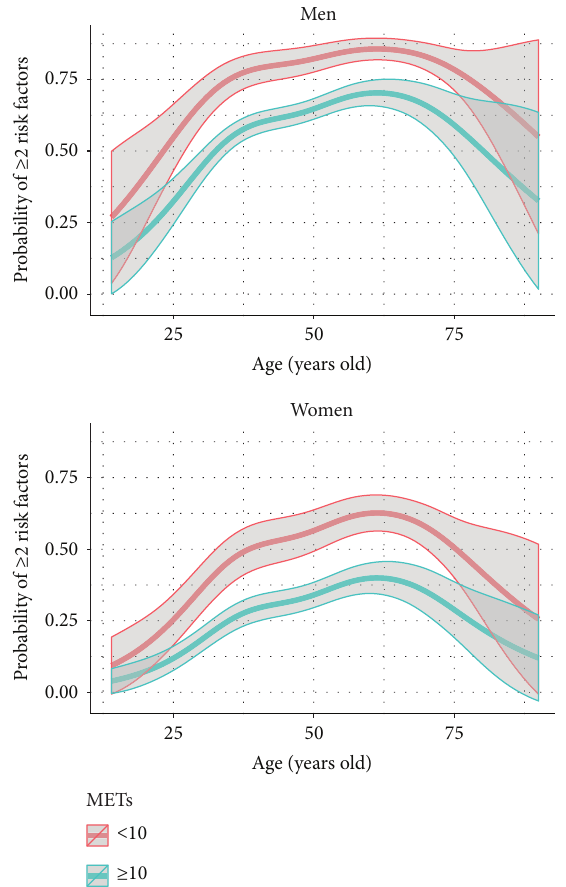
Figure 1: Odds proportional models showing the probability of presenting ≥ 2 risk factors according to aerobic capacity and age in men and